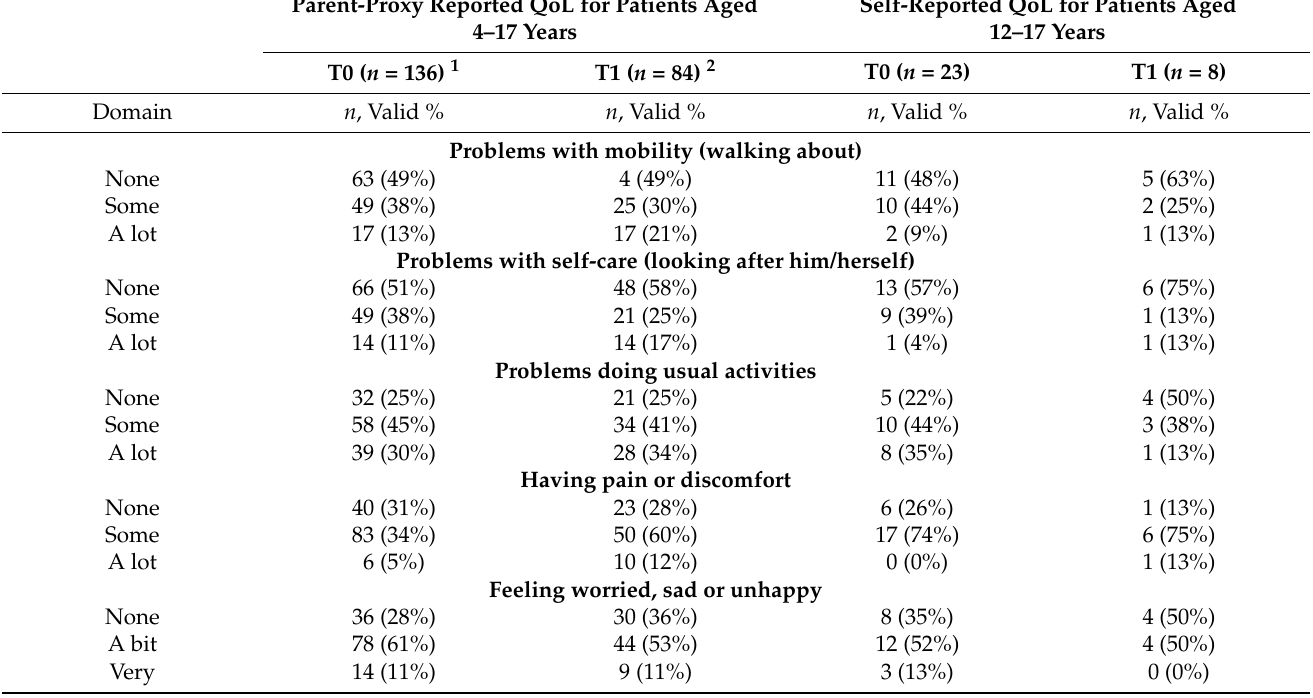
Figure 3. Patient self-report and parent-proxy QoL on EQ-VAS at T0 and T1. Table 3. Patient QoL assessed via parent-proxy and patient self-report on the EQ-5D-Y scale. Parent-Proxy Reported QoL for Patients